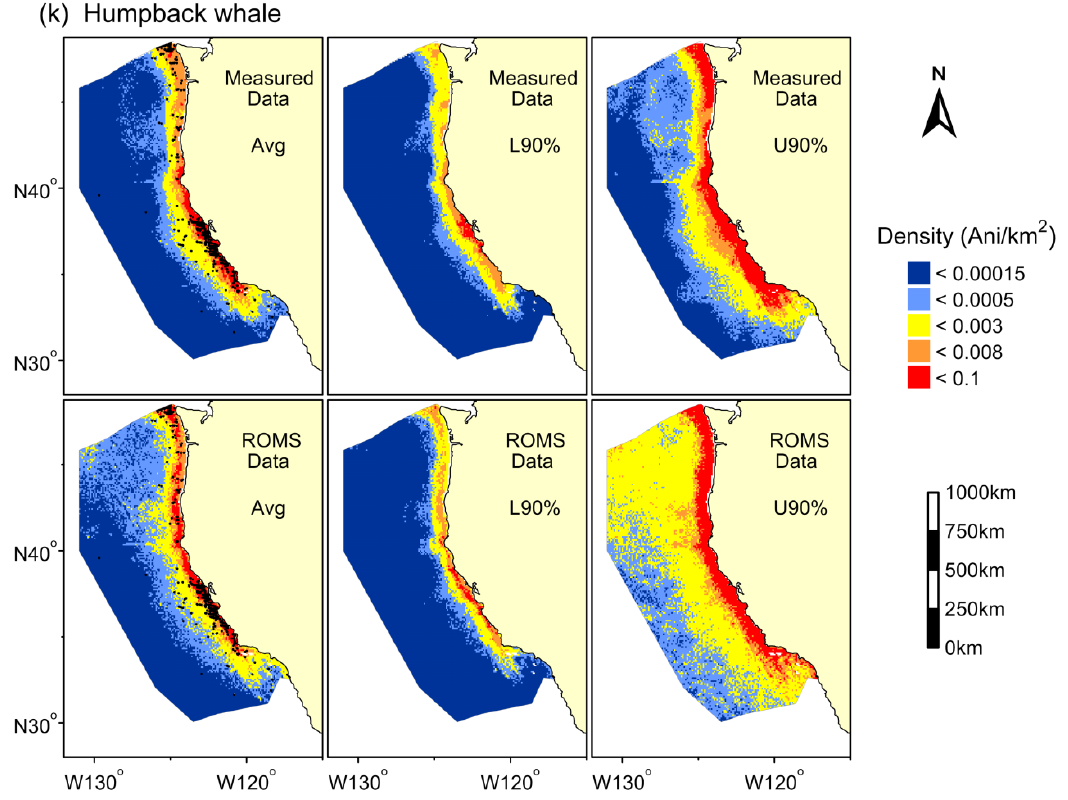
Figure 2. Predicted densities and uncertainty measures from the habitat-based density models built with measured data (top panels) and ROMS output (bottom panels), for ( a ) striped dolphin, ( b ) short-beaked common dolphin, ( c ) long-beaked common dolphin, ( d ) common bottlenose dolphin, ( e ) Risso’s dolphin, ( f ) Pacific white-sided dolphin, ( g ) northern right whale dolphin, ( h ) Dall’s porpoise, ( i ) fin whale, ( j ) blue whale, and ( k ) humpback whale. Panels show the multi-year average (Avg) density, and 90% confidence limits (L90% and U90%). Predictions are shown for the study area (1,141,800 km 2 ). Density ranges were selected to encompass all values within the confidence limits. Black dots show actual sighting locations from the ship surveys.